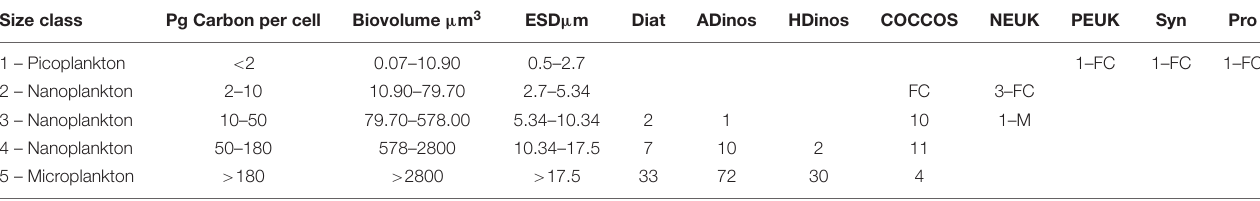
TABLE 1 | List of the five plankton classes defined according to: Carbon per cell content, biovolume, and size as equivalent spherical diameter (ESD).